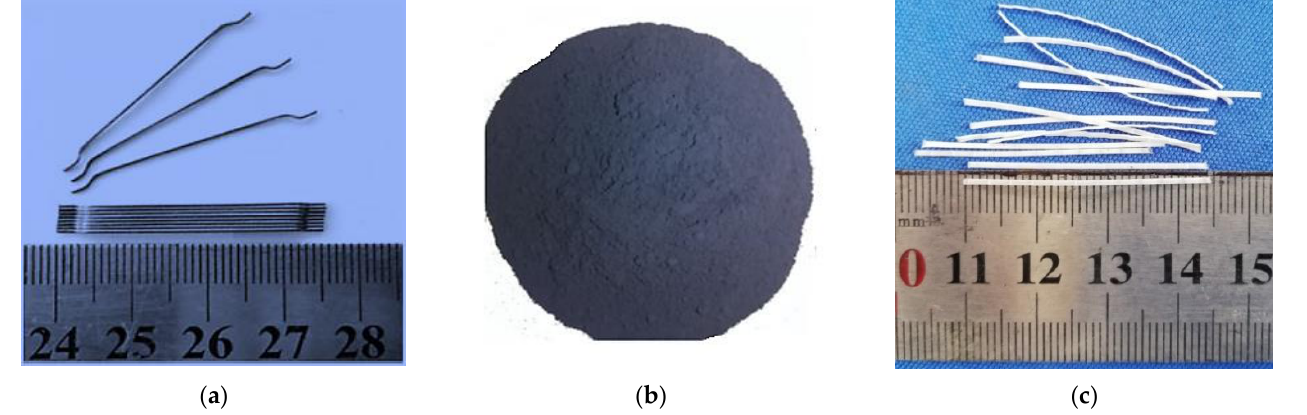
Figure 1. Dimension and shape of ( a ) steel fibers ( b ) nanocarbon black ( c ) polypropylene fibers. Table 1. Physical properties of fiber and filler materials.